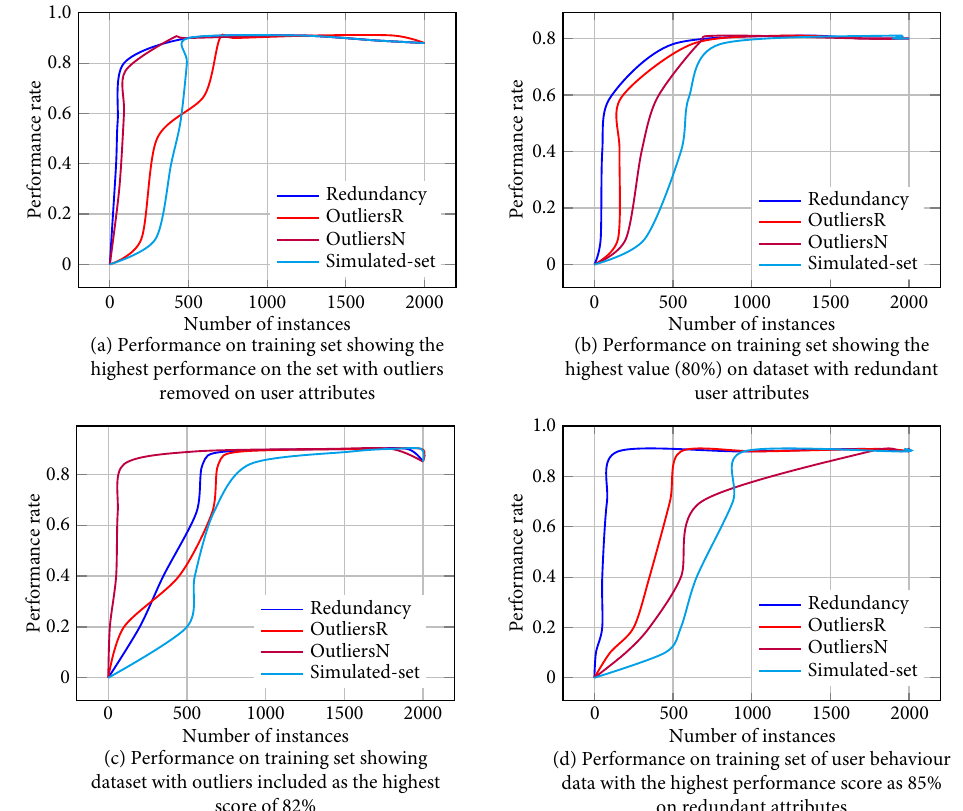
Fig. 5 Performance on dataset for both training and test sets showing scores for four different scenarios on user behaviour data generated during the experimental setup.